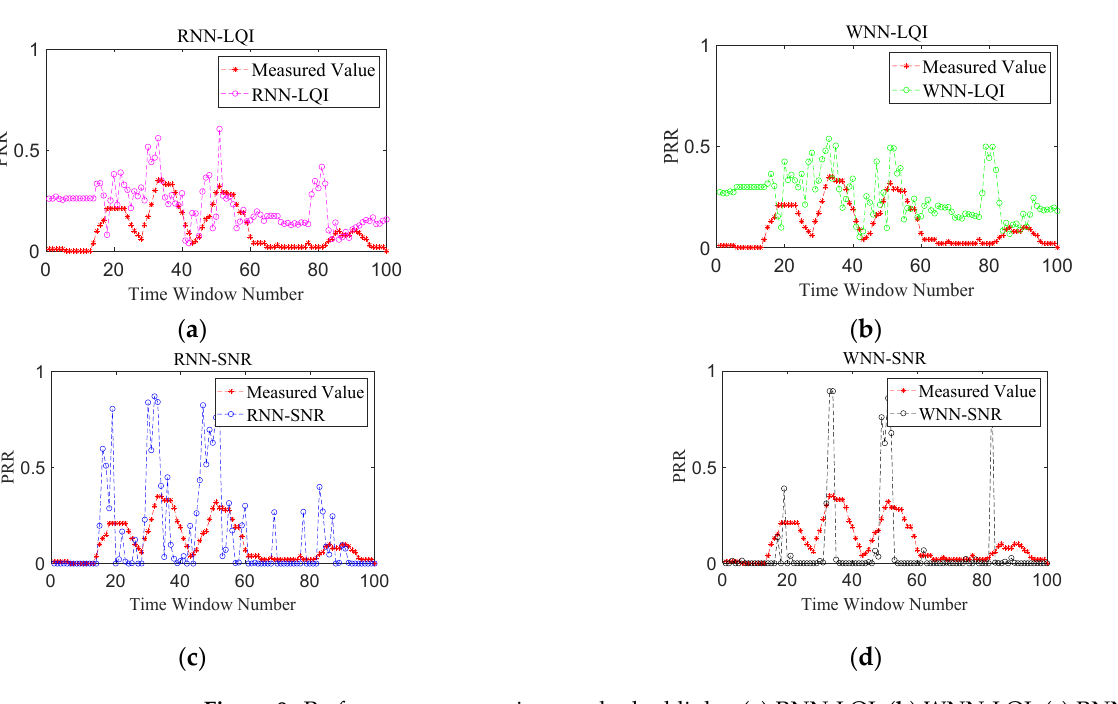
Figure 9. Performance comparison under bad links. ( a ) RNN-LQI, ( b ) WNN-LQI, ( c ) RNN-SNR, ( d ) WNN-SNR.